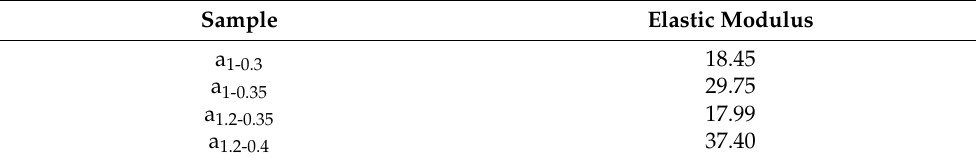
Table 3. Elastic modulus of different types of octahedral porous